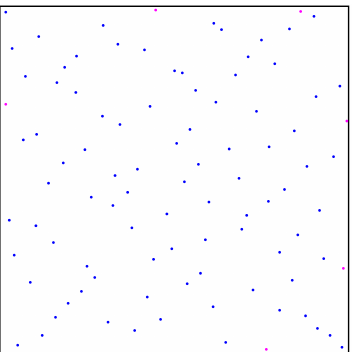
Figure 5. Sampling points obtained by quasi-random sampling